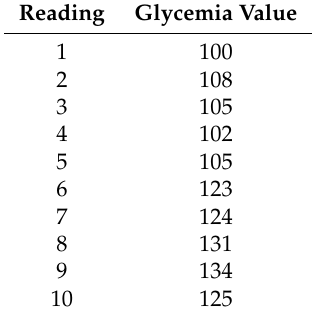
Table 1. Blood glucose values for a simulated patient.